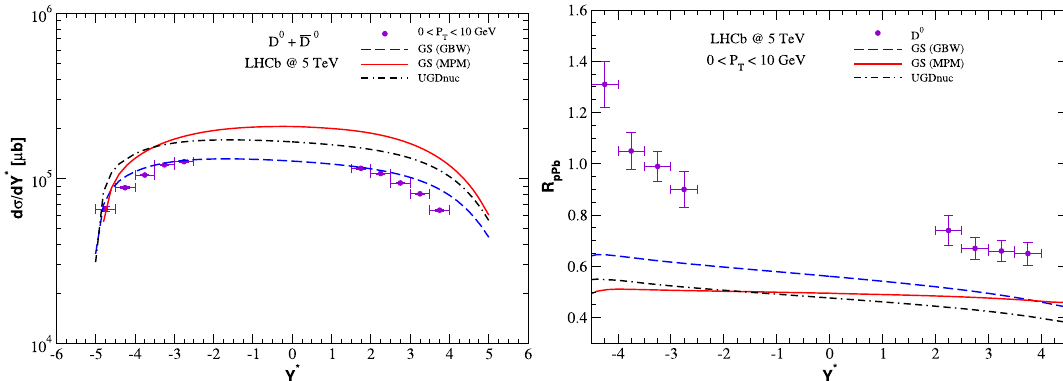
Fig. 8 The differential cross section (left panel) and the nuclear modi- fication factor (right panel) for D 0 meson production in pPb collisions √ s = 5 TeV as a function of Y ∗ in the forward and backward con- at